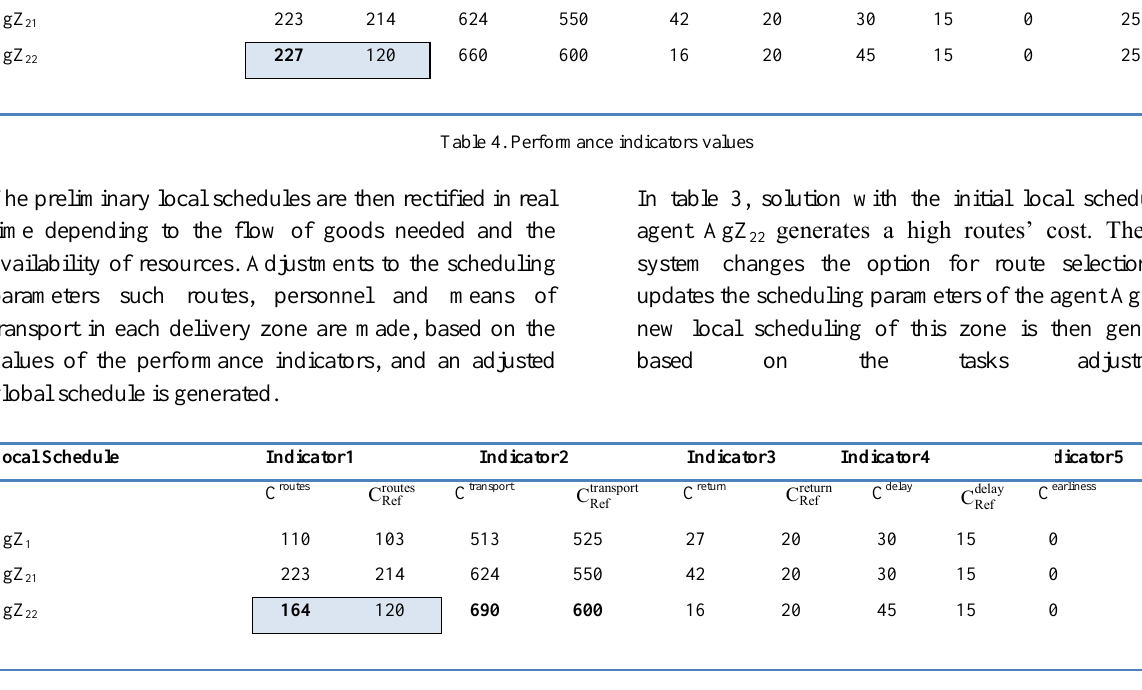
Table 5. Performance indicators values after re-schedulin